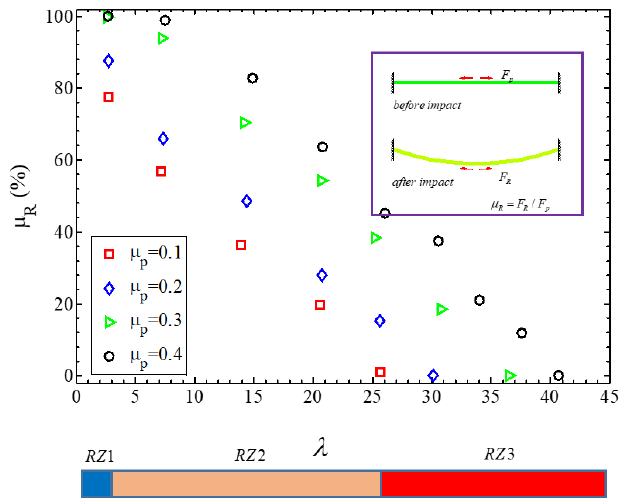
Figure 17. The correlation of the residual stress with the input kinematic energy and pre − stressed level (Zone for RZ1, RZ2 and RZ3 represent none, partial, and total stress loss, respectively).